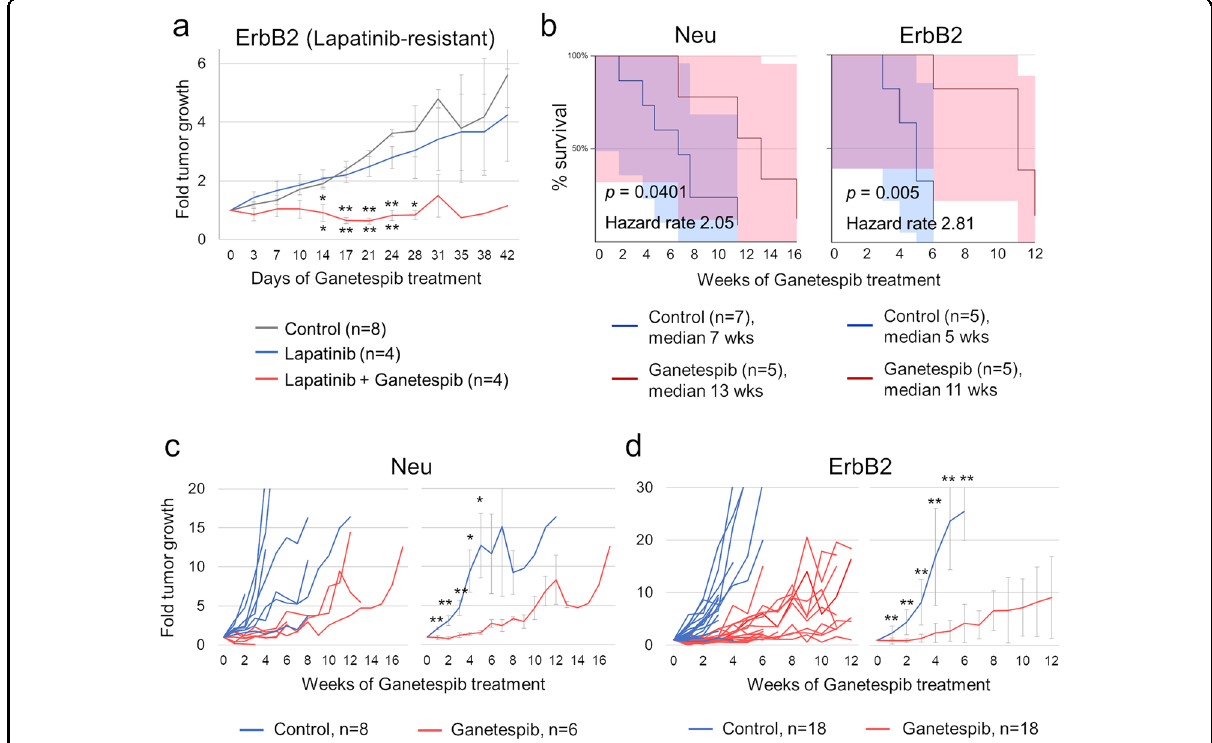
Fig. 1 Ganetespib is effective in mouse models of HER2-positive breast cancer, but eventually evokes acquired resistance. a Tumor volume over time in Lapatinib-resistant ErbB2 mice. After acquiring Lapatinib resistance, mice were treated with Vehicles, Lapatinib alone (which was no longer effective), or Lapatinib and Ganetespib together. Tumor size was normalized to the respective initial size (when treatments started), which was on average 2,501 ± 156 mm 3 . Mean ± SEM, * p < 0.05, ** p < 0.01 (top asterisks, vs. Vehicles; bottom asterisks, vs. Lapatinib alone), unpaired two-tailed Student ’ s t -test. b Overall survival of Neu ( left ) and ErbB2 ( right ) mice with or without (Control) Ganetespib injections, weeks after the onset of the autochthonous mammary tumors (when treatments started). Note that Ganetespib approximately doubles the overall survival in both models. Kaplan – Meier analysis, p , Log Rank statistics. Shaded areas are 95% con fi dence interval. c , d The dynamics of tumor growth over time in Neu ( c ) and ErbB2 ( d ) mice with or without (Control) Ganetespib injections performed as in b . Note that after the initial period of regression/stagnation for about 4 weeks, tumors in both models regrow due to acquired resistance. Tumor size was normalized to their respective initial size (when treatments started), which was 233 ± 22 mm 3 and 251 ± 23 mm 3 ( c ); 157 ± 45 mm 3 and 146 ± 40 mm 3 ( d ) for Control and Ganetespib groups, respectively. c , d , left growth of individual tumors, c , d , right average tumor growth. Mean ± SEM, * p < 0.05, ** p < 0.01, unpaired two-tailed Student ’ s t